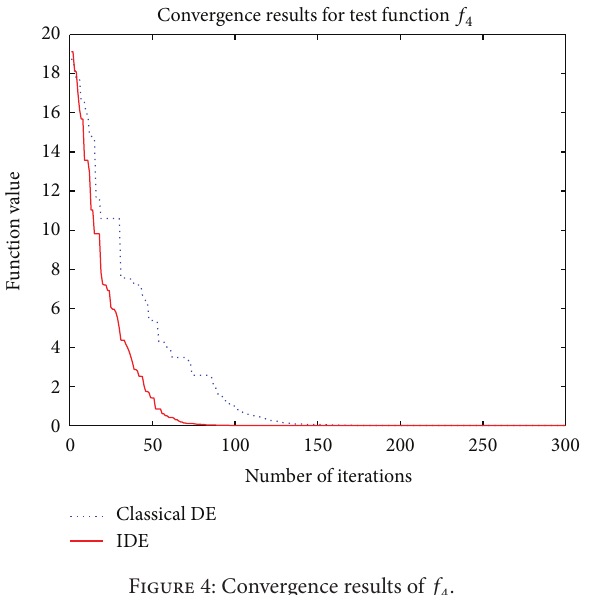
Figure 5: The convergence curves of DE and